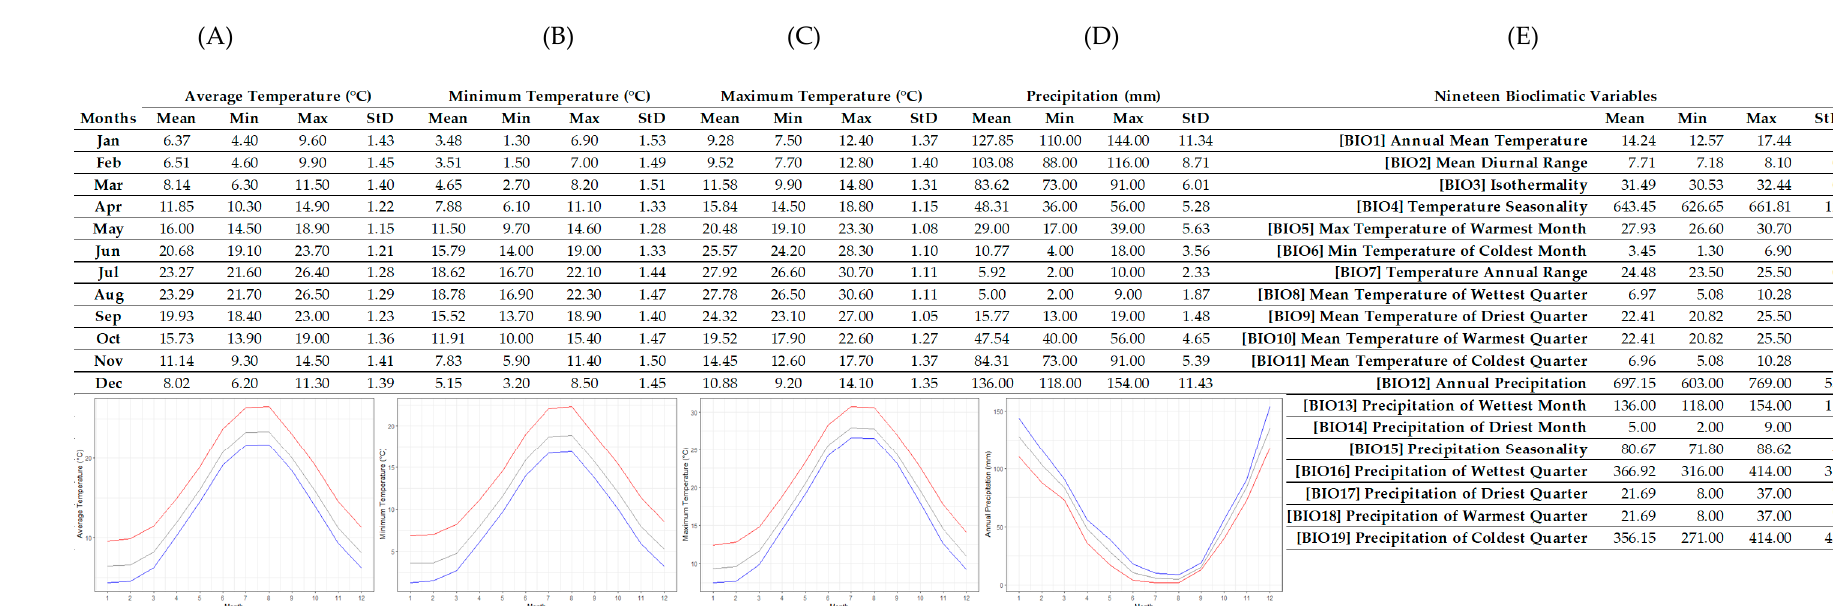
Figure 2. R-derived ecological profile of the wild-growing populations of Sideritis sipylea based on thirteen known Greek localities (N = 13) with WorldClim (version 2.1) data-mined values (minimum, maximum, average and standard deviation) for temperature ( A – C ), precipitation ( D ) and 19 bioclimatic variables ( E ). Line graphs ( A – C ) illustrate the minimum (blue), maximum (red) and mean (gray) monthly temperature (°C). Line graph ( D ) illustrates the minimum (red), maximum (blue) and mean (gray) monthly precipitation (mm).